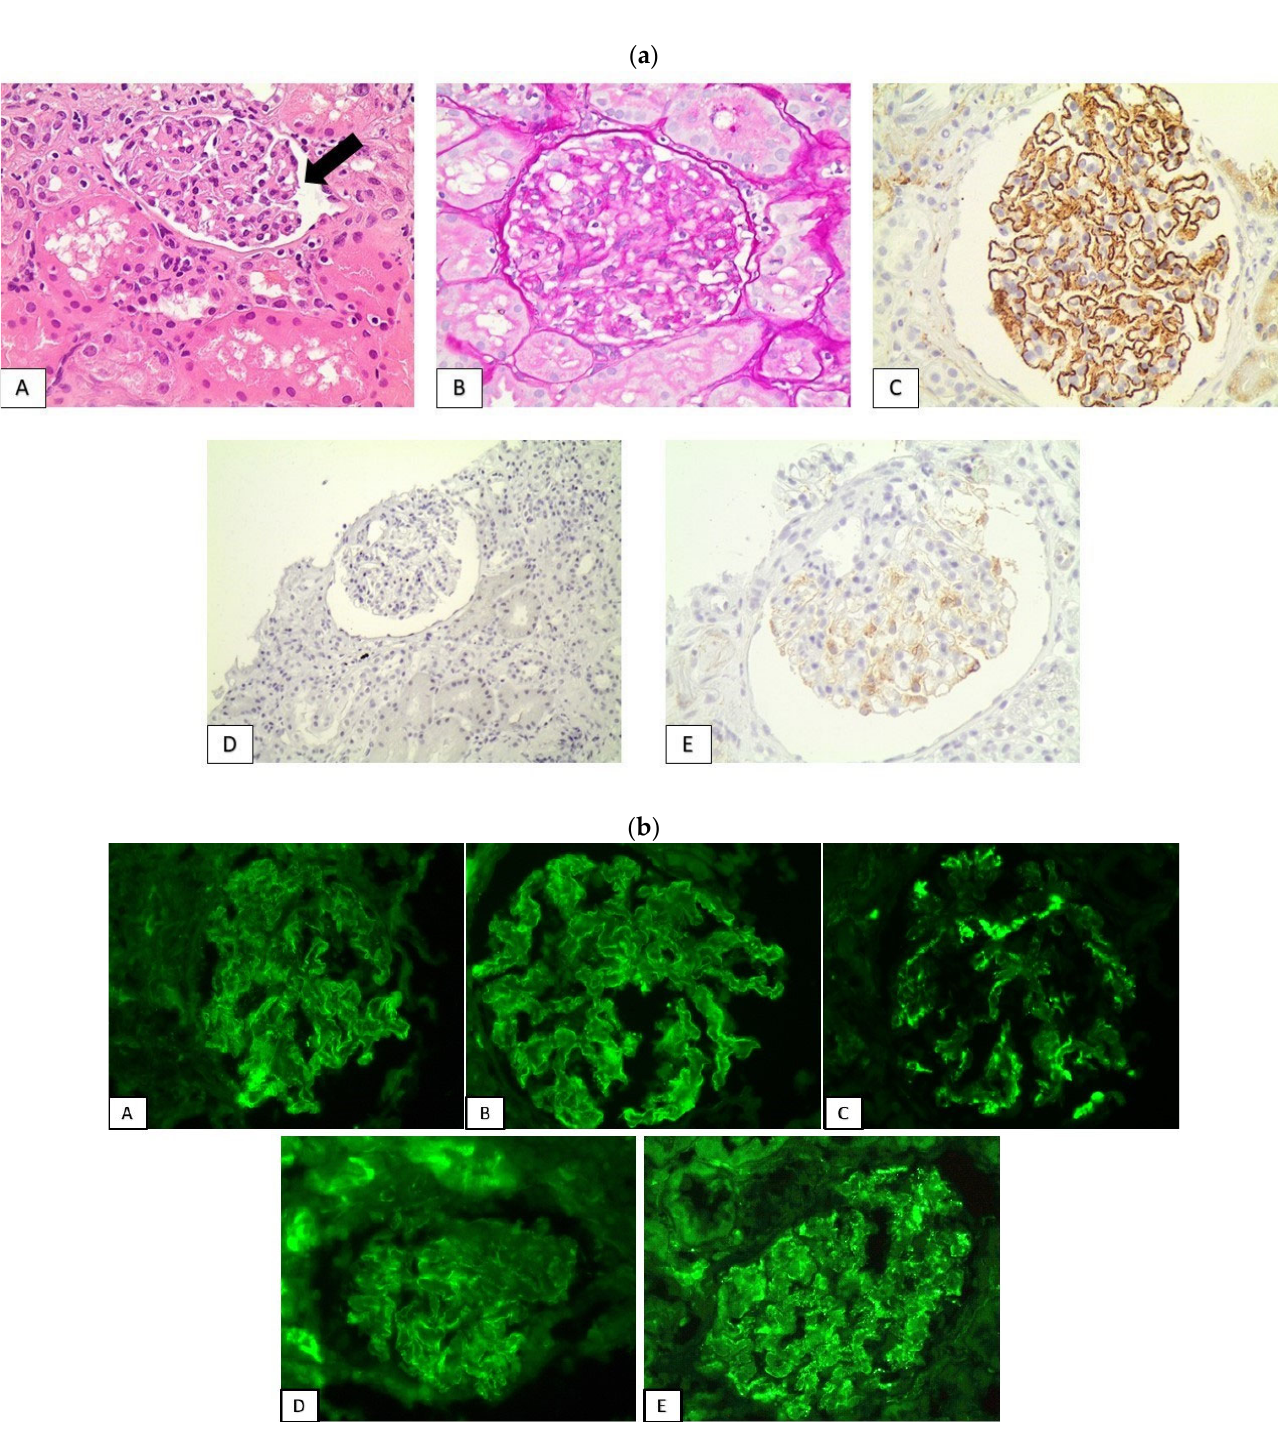
Figure 2. Secondary “lupus ‐ like” membranous glomerulopathy. ( a ) Glomeruli showcased the diffuse thickening of glomerular basement membranes (( A ): H&E ×200, ( B ): PAS ×200), while immuno ‐ histochemistry revealed the diffuse granular deposition of C4d along glomerular basement membranes (( C ): C4d ×400). Immunohistochemical evaluation for primary membranous glomerulopathy markers IgG4 and PLA2r was negative (( D ): IgG4 ×200, ( E ): PLA2r ×400). ( b ) A “full house” pattern, with granular IgG, IgM, IgA, C3 and C1q deposits along glomerular capillaries basement membranes was observed in immunofluorescence (( A ): IgG ×400, ( B ): IgA ×400, ( C ): IgM ×400, ( D ): C3 ×400, ( E ): C1q ×400). IgA glomerulonephritis: A 73 ‐ years old male (patient 1) with a medical history of hypertension received PD ‐ L1 inhibitor atezolizumab and experienced kidney injury within twelve months upon treatment initiation. His serum creatinine level was 2 mg/dL,